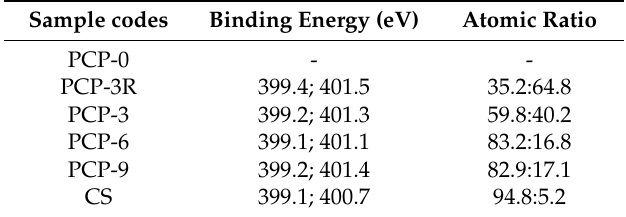
Table 5. Binding energy and atomic ratio of N 1s peaks in XPS